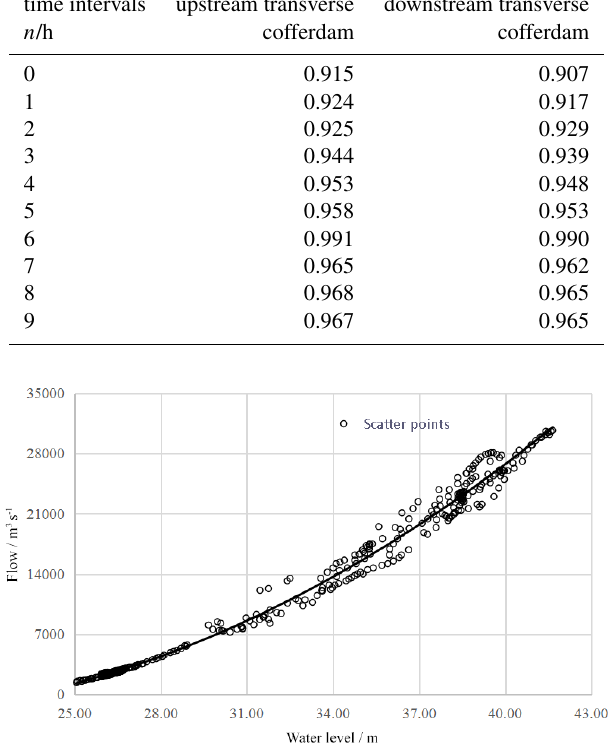
Figure 2. The scatter diagram with T − 6h time flow of Wuxuan and T time water level of upstream transverse cofferdam.